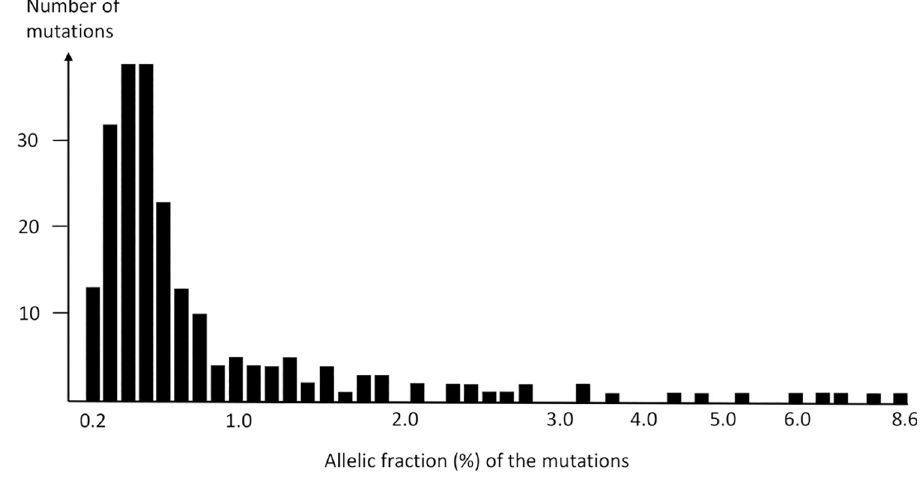
Fig 1. Participants’ CD8+ cell somatic mutation allelic fraction